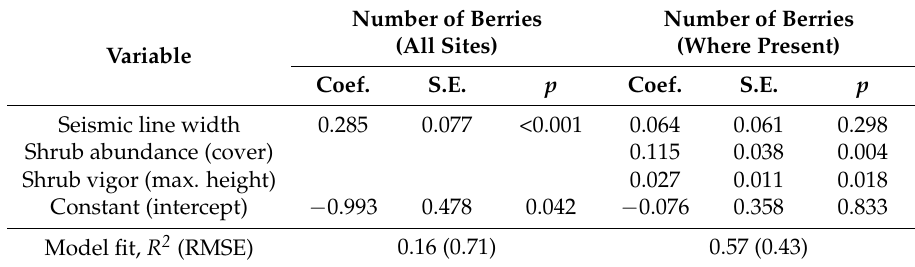
Table 5. Linear regression results relating forest gap (seismic line) width to berry production (log 10 transformed) in Vaccinium myrtilloides